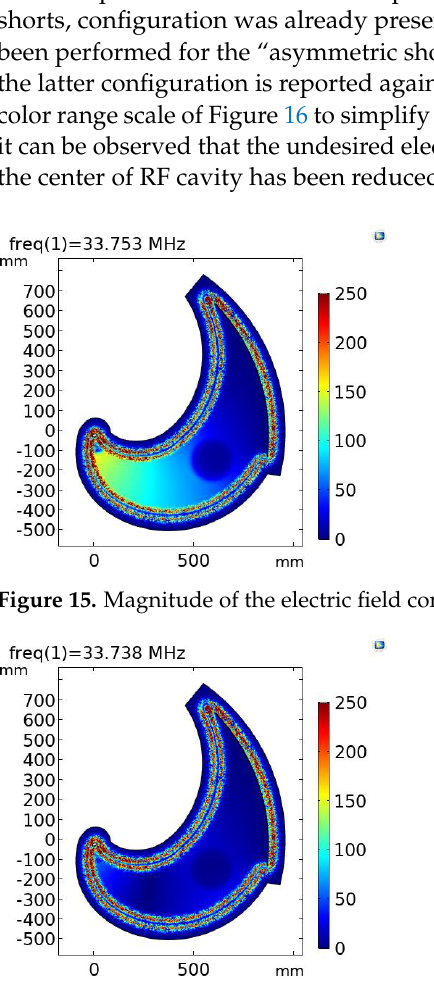
Figure 16. E ⊥ produced by the asymmetric sliding short configuration at 33.7416 MHz It is worth noticing that the applied asymmetry keeps unaltered the accelerating field component E (cid:107) , parallel to the middle plane, as it is possible to see in Figure